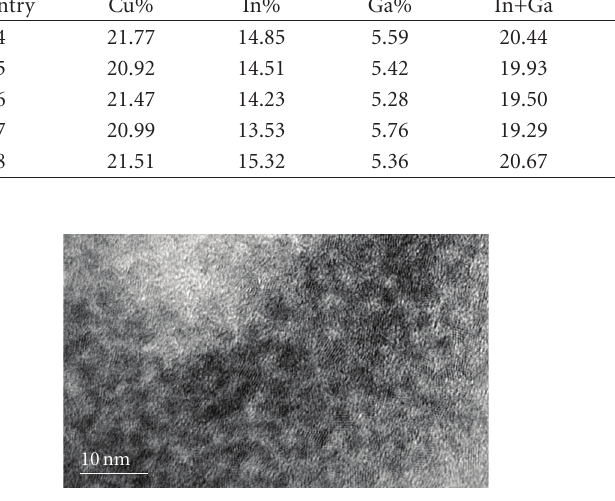
Figure 6: HRTEM image of CuIn 0 . 61 Ga 0 . 39 S 2 nanoparticles at 200 ◦